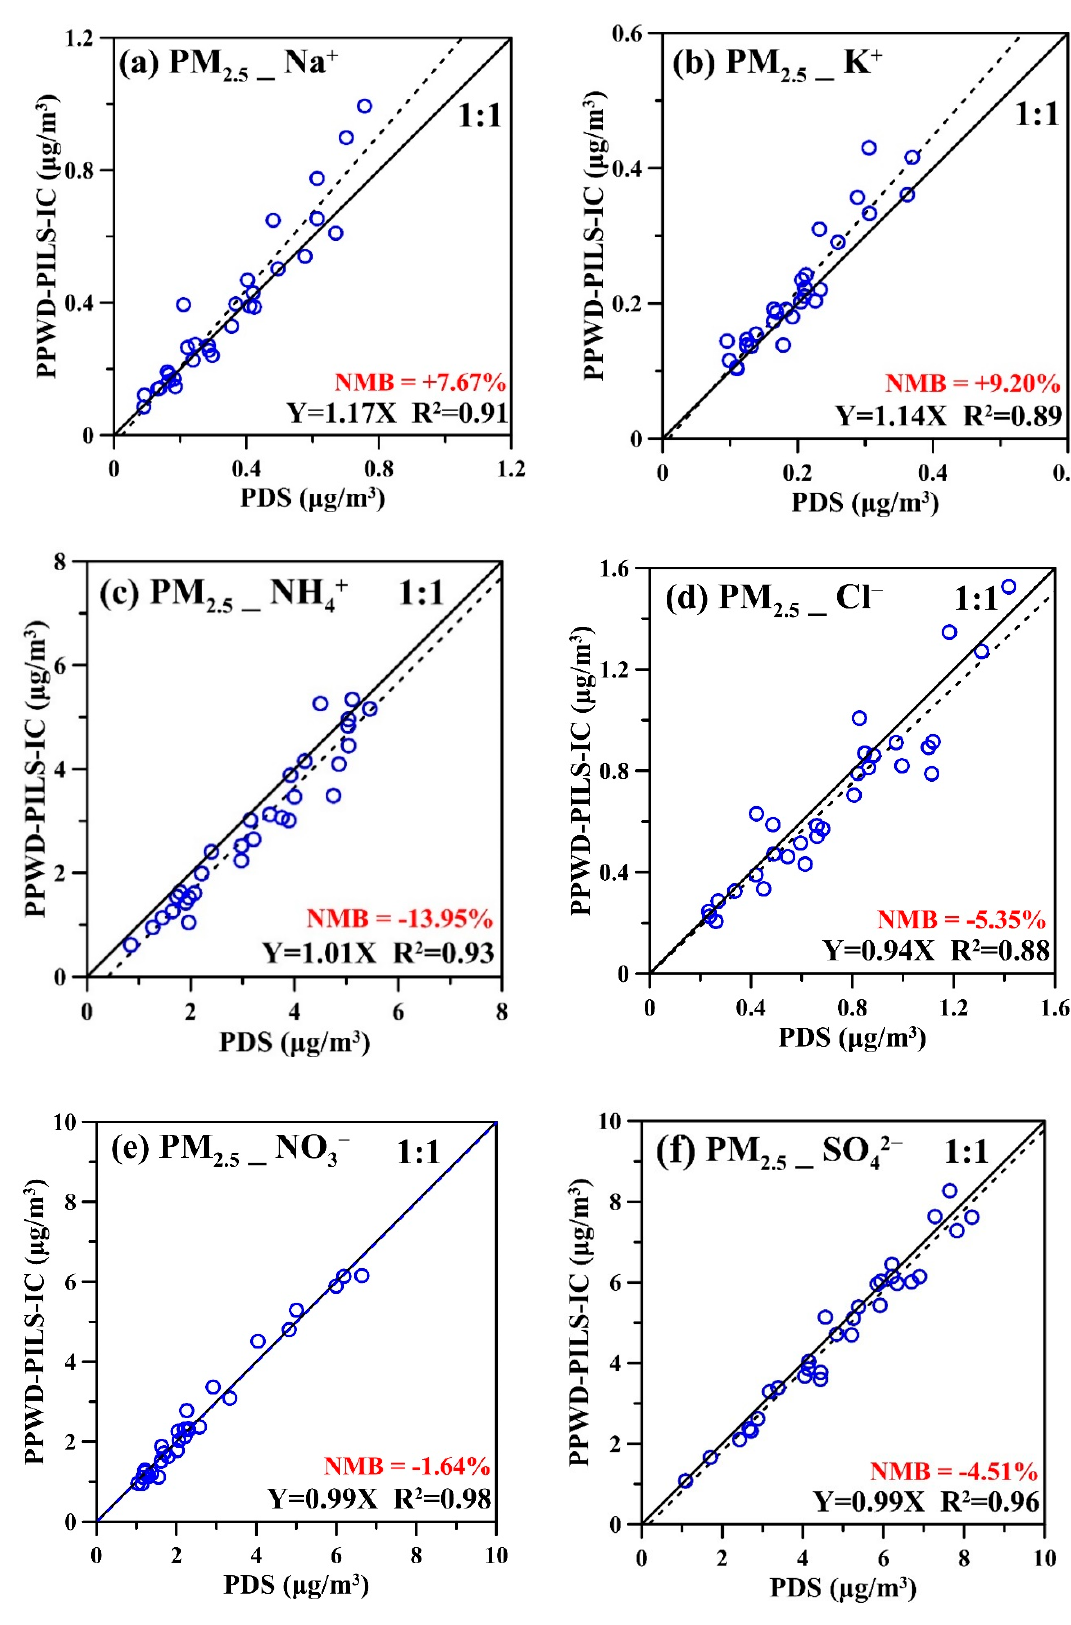
Figure 4. Correlation plot of the parallel plate wet denuder and particle into liquid sampler coupled with ion chromatography (PPWD-PILS-IC) and the PDS for the water-soluble inorganic species in PM 2.5 . ( a ) Na + ; ( b ) K + ; ( c ) NH 4 + ; ( d ) Cl − ; ( e ) NO 3 − ; and ( f ) SO 4 2 − .